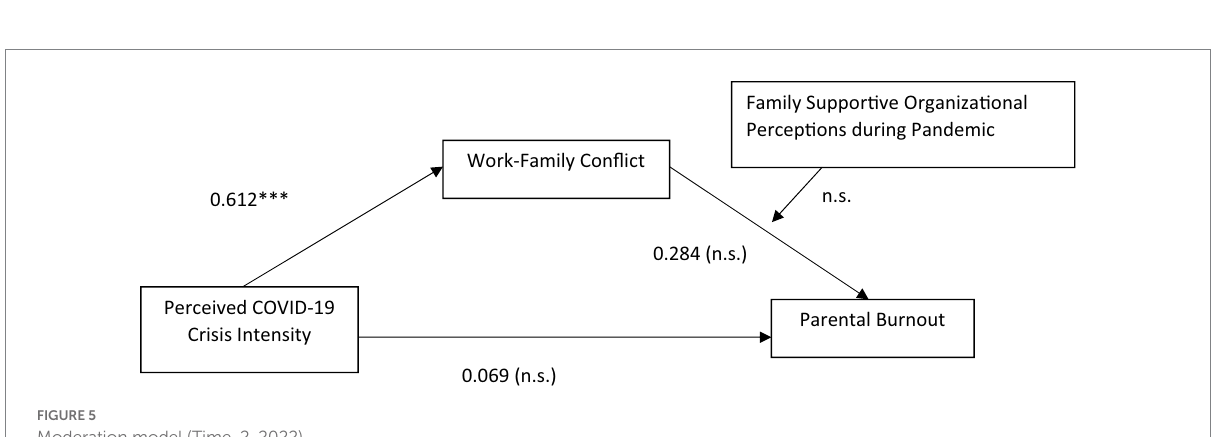
FIGURE 4 Moderation model (Time-1, 2021).